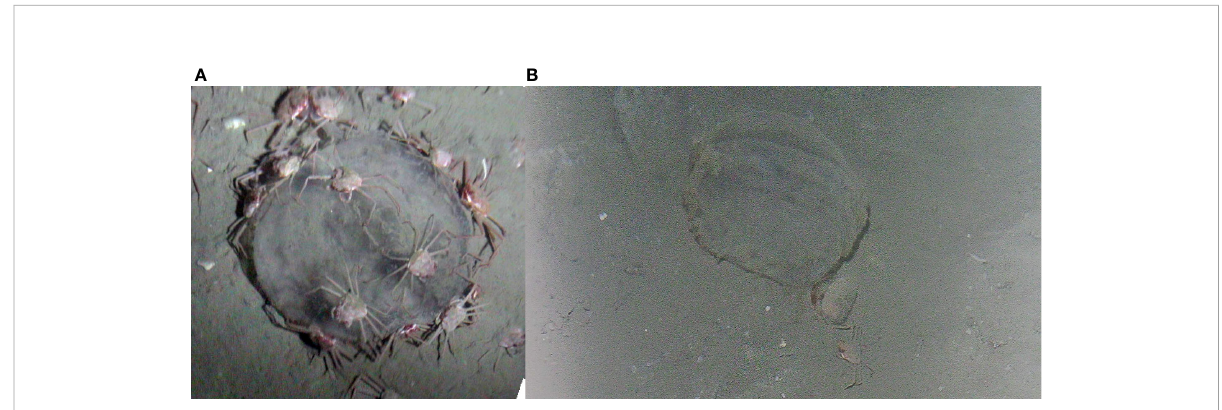
FIGURE 5 Jelly fi sh laying on the seabed. (A) The carcass is being scavenged by numerous small individuals of grooved tanner crab (image taken in October 2010). (B) Consumption of the carcass has not started yet, although a tanner crab individual is visible (image taken on December 08